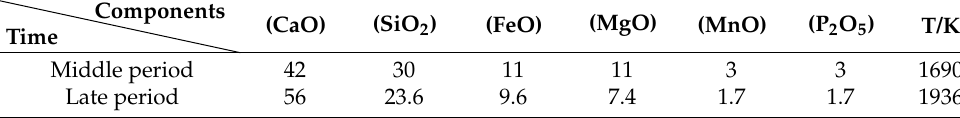
Table 7. Components of the slag during the middle and late periods in a heat converter process (wt%).